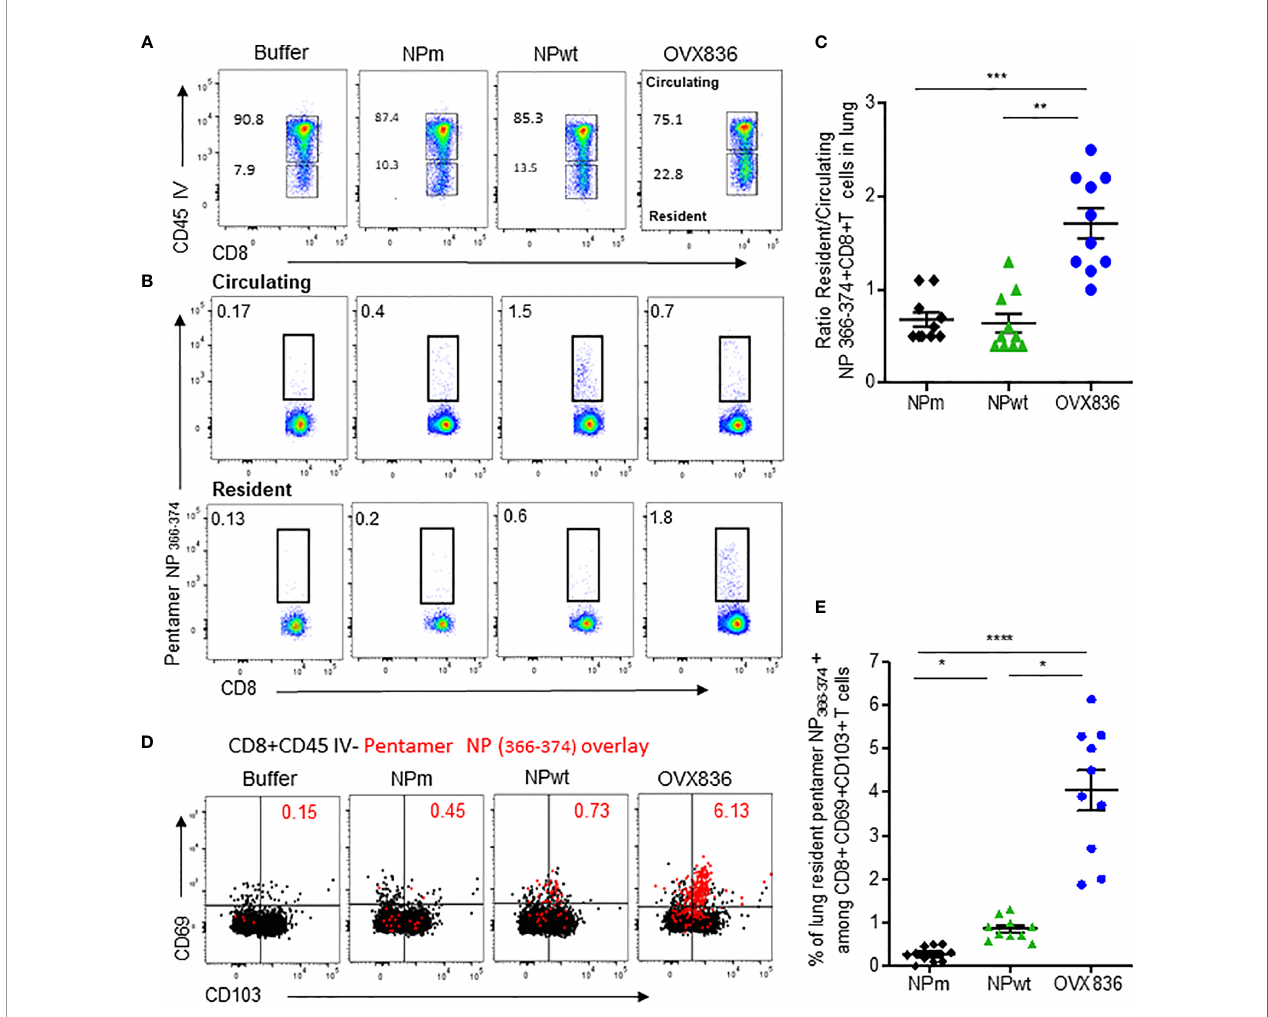
FIGURE 5 | OVX836 vaccine generates lung NP-speci fi c CD8+ TRM cells. C57BL/6 mice (n = 9 – 10 in each group) were immunized twice 3 weeks apart, with 30 µg of NPm, NPwt, OVX836, or buffer (control) by the IM route. At D28, anti-CD45 Abs were administered by the IV route to label vascular cells. (A) Representative fl ow cytometry analysis of circulating (CD45+) and resident (CD45 − ) distribution in the lung after immunization. (B) Representative fl ow cytometry analysis of circulating and resident lung NP 366 – 374 -speci fi c CD8+ T-cells using H2-Db NP 366 – 374 pentamer staining. (C) Ratio resident/circulating of percent H-2Db NP 366 – 374 Pentamer + CD8+ T-cells of two independent experiments. (D) Representative overlay plots of fl ow cytometric analysis showing distribution of lung-resident H-2Db NP 366 – 374 Pentamer + CD8 + CD45 − T-cell (red dots) TRM generated following vaccination among the CD69+CD103+ (black) population. (E) Graph representing percent resident H- 2Db-NP 366 – 374 Pentamer+ among CD8+CD69+CD103+ cells in the lung after vaccination of two pooled independent experiments. Individual data and mean ± SEM are represented. Differences were assessed by one-way ANOVA followed by Tukey ’ s multiple comparison test. *p < 0.05, **p < 0.01, ***p < 0.001, ****p <